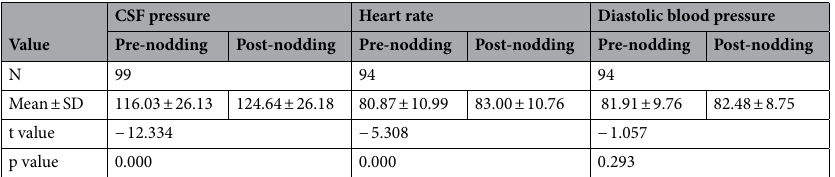
Table 6. Comparison of the CSF pressure, heart rate and diastolic blood pressure obtained before and after the head-nodding period (paired t test). CSF pressures are given in mmH 2 O. The heart rates are given in times/ min. The diastolic blood pressures are given in mmHg.